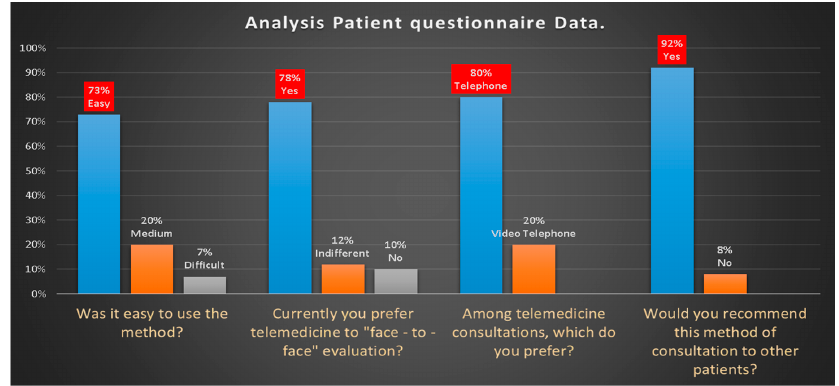
Figure 7. Analysis patient questionnaire data.